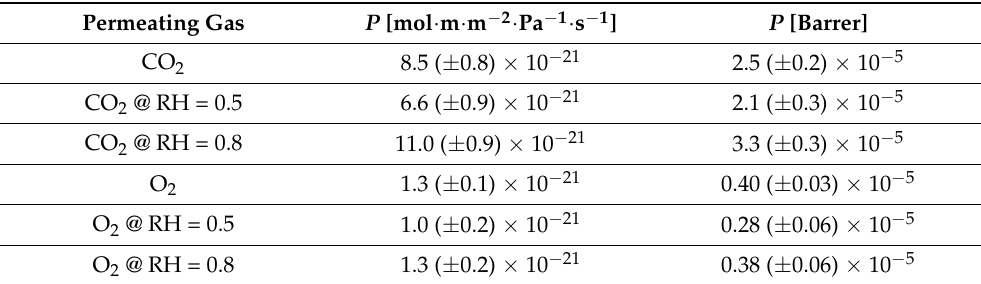
Table 3. Estimated permeability coefficients of CO 2 and O 2 through a graphene nanolayer at different R.H.